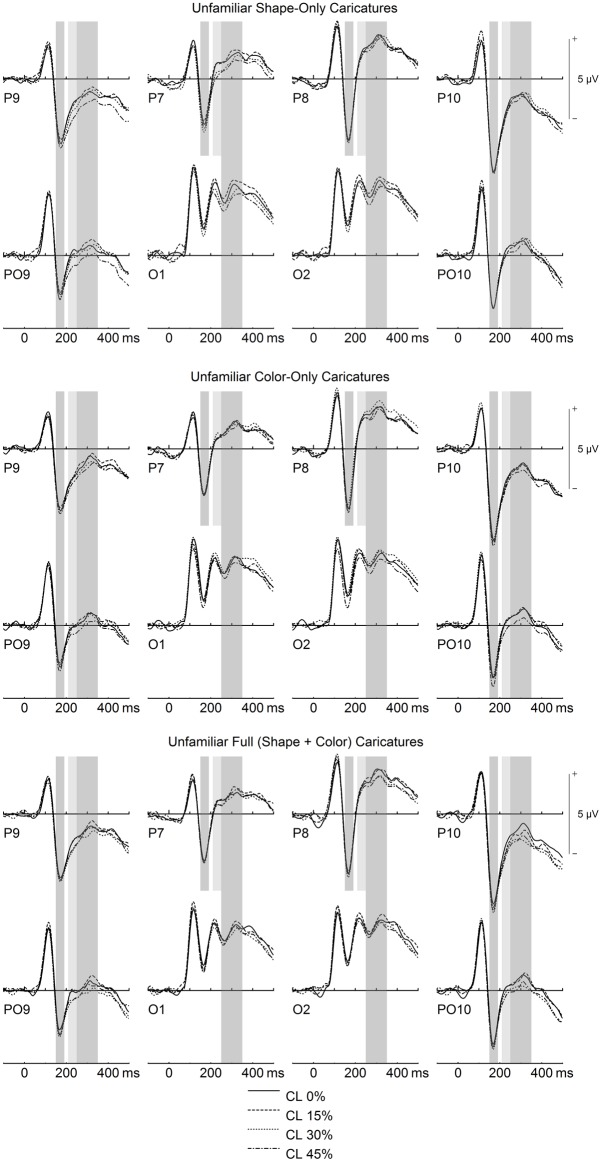
Early ERP caricature level effects for unfamiliar faces.Gray-shaded areas denote time-windows of interest for N170 (150–190 ms), P200 (210–250 ms), and N250 (250–350 ms). Note decreasing P200 with increasing caricature level for shape-only and full (shape + color) caricatures.